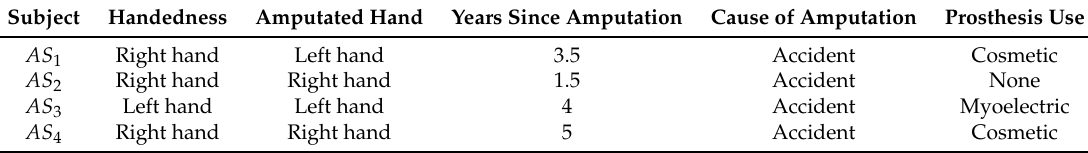
Table 1. Detailed information about the amputation associated with each subject in DB 2